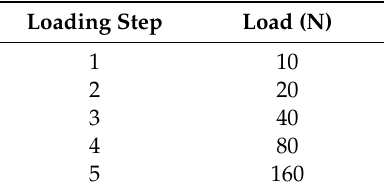
Figure 8. Meshes sensorized during the first experimental session. Each mesh has been labelled with the number shown in the image. Table 1. Loads applied to the wire mesh both in experimental and numerical activity-first test sessions (standard gravity g assumed equal to 10 m/s 2 ).